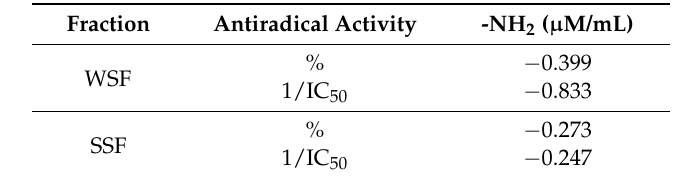
Table 3. The Pearson’s correlation coefficients between ABTS 1/IC 50 values and the content of protein degradation